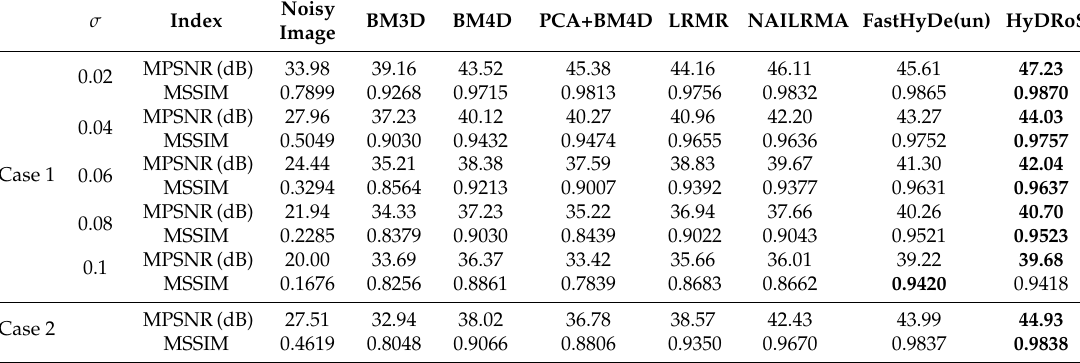
Table 1. Quantitative assessment of the different denoising algorithms applied to AVIRIS hyperspectral data at Cuprite Mining